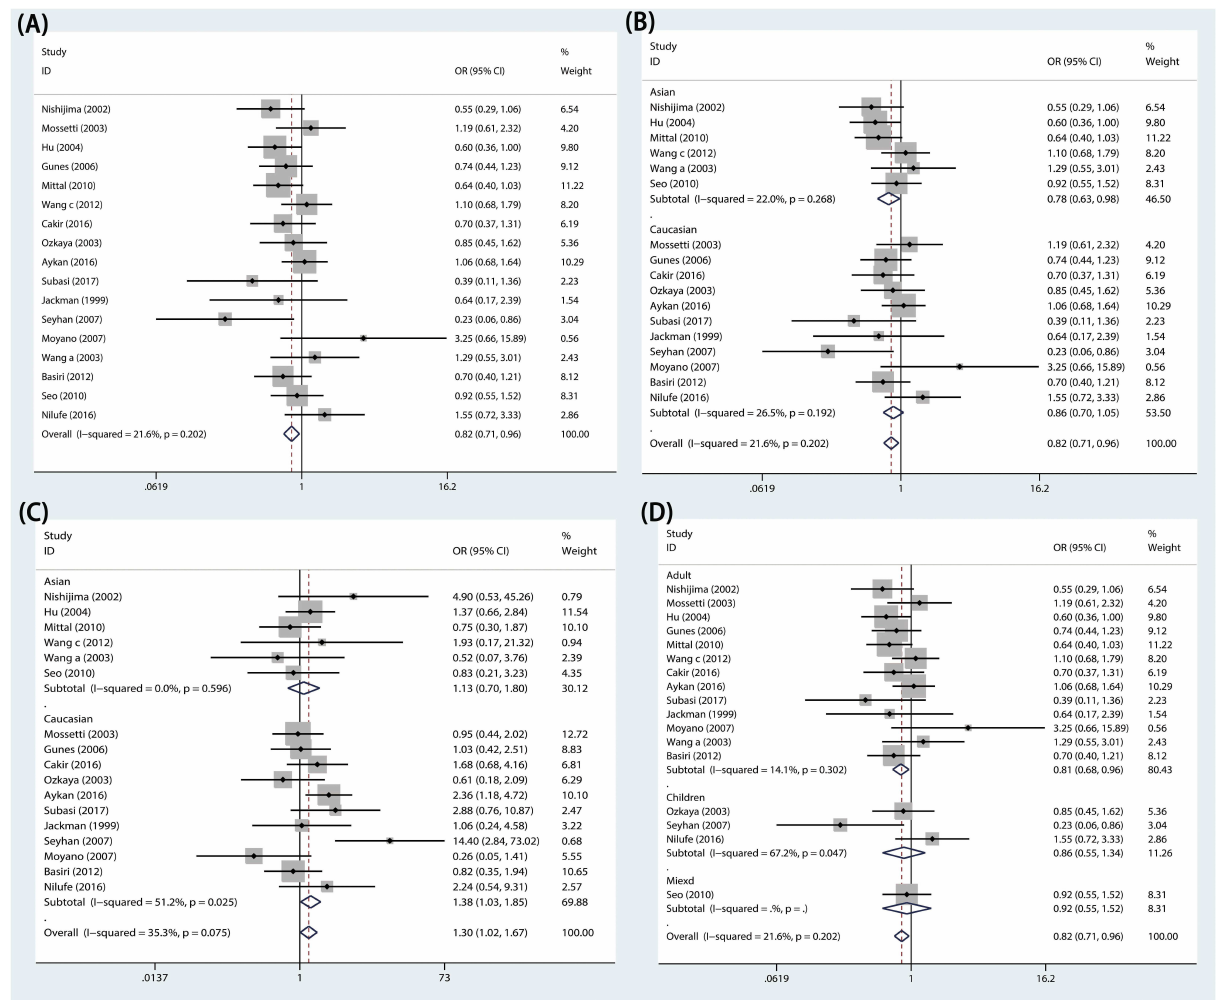
FIGURE 2 | Forest plots of VDR TaqI variant and urolithiasis: (A) overall for tt vs. TT, (B) Asian population for TT vs. Tt + tt, (C) Caucasian population for tt vs. TT, and (D) adults for TT vs. Tt +